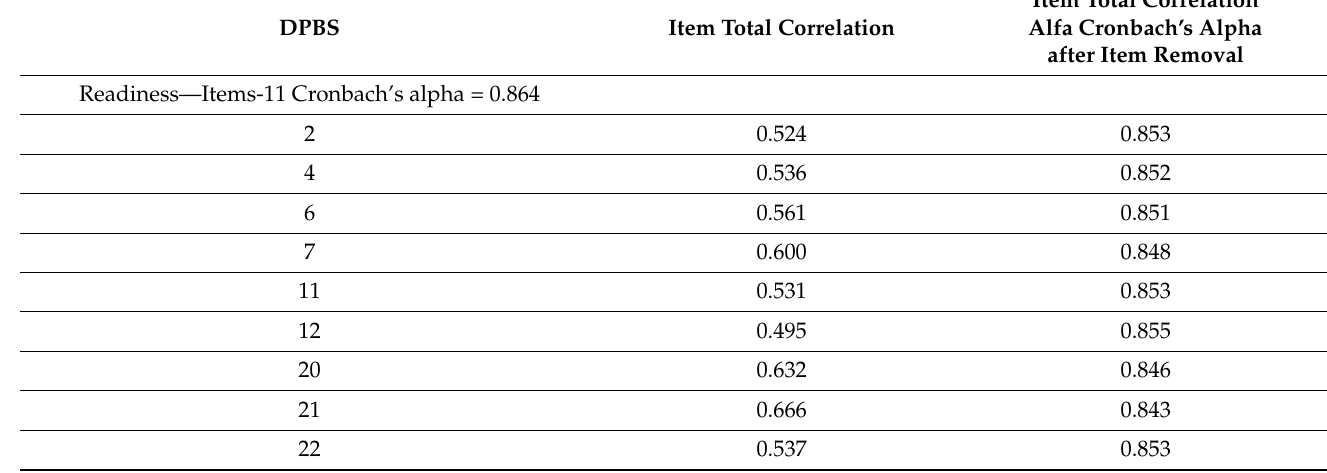
Table 8. Cronbach’s Alpha coefficient in the individual